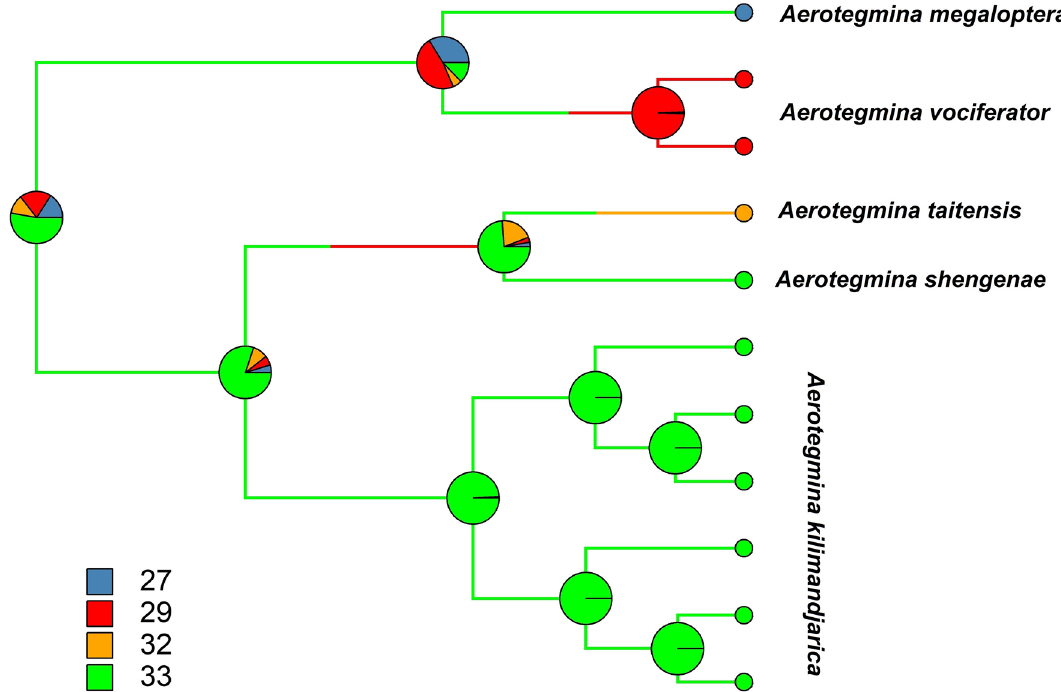
Figure 6. The ancestral character states for number of chromosomes mapped on the modified Aerotegmina Beast chronogram. The different colour branches present different chromosome numbers (explained by squares in the left corner). Circles represent the posterior probability of being in each state across all the edges and nodes of the